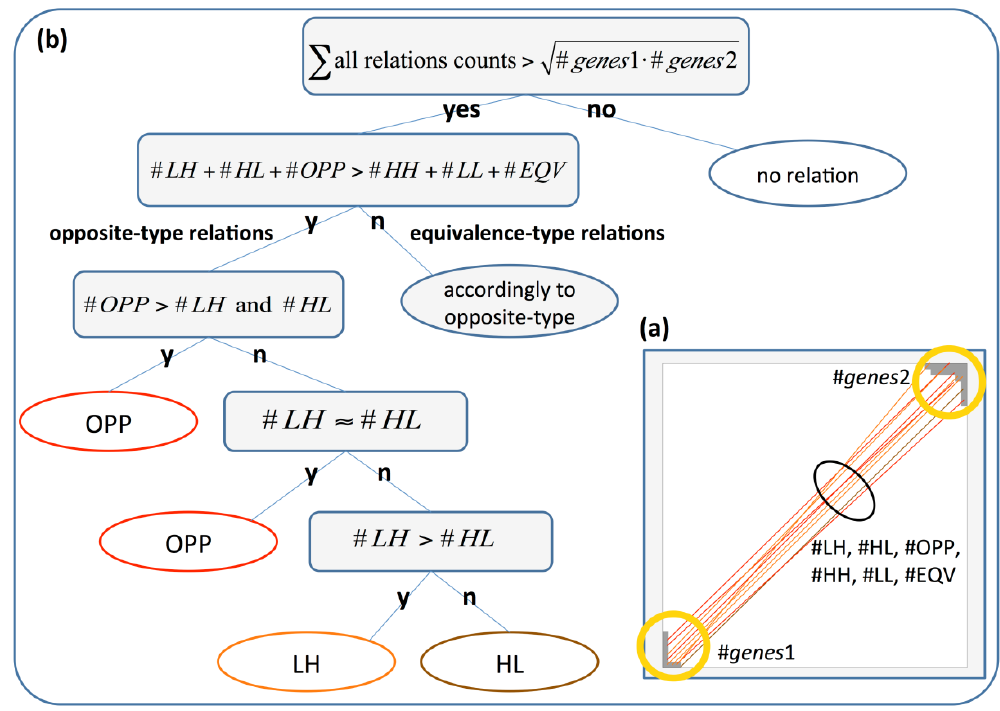
Figure 3: Decision tree to identify spot module implications from gene level implications. Boolean implications detected and counted for all pairs of genes from two spots are identified first (panel a). Then, the obtained numbers are employed in a decision tree to designate the respective relation between the two spots evaluated (panel b). Note that the part of the tree referring to equivalence-type relations is likewise the part of the opposite-type